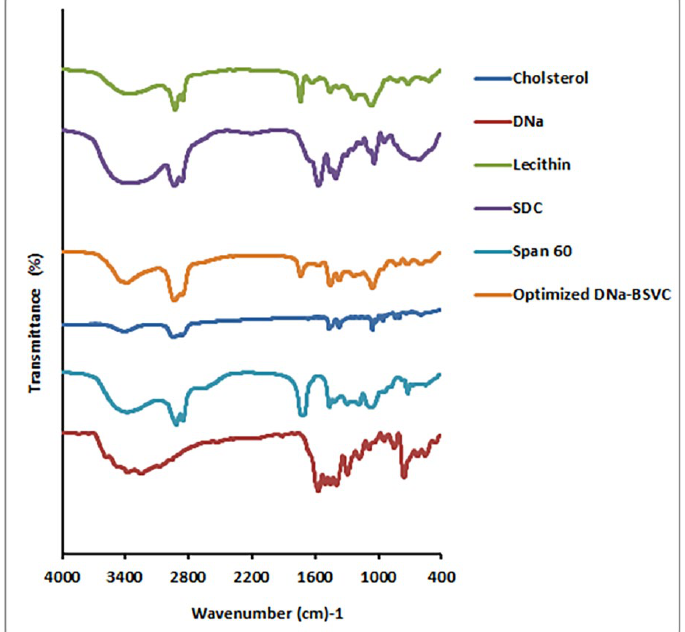
Figure 6. FTIR spectra of DNa, lecithin, cholesterol, SDC, Span 60 and optimized BSVC formulation.